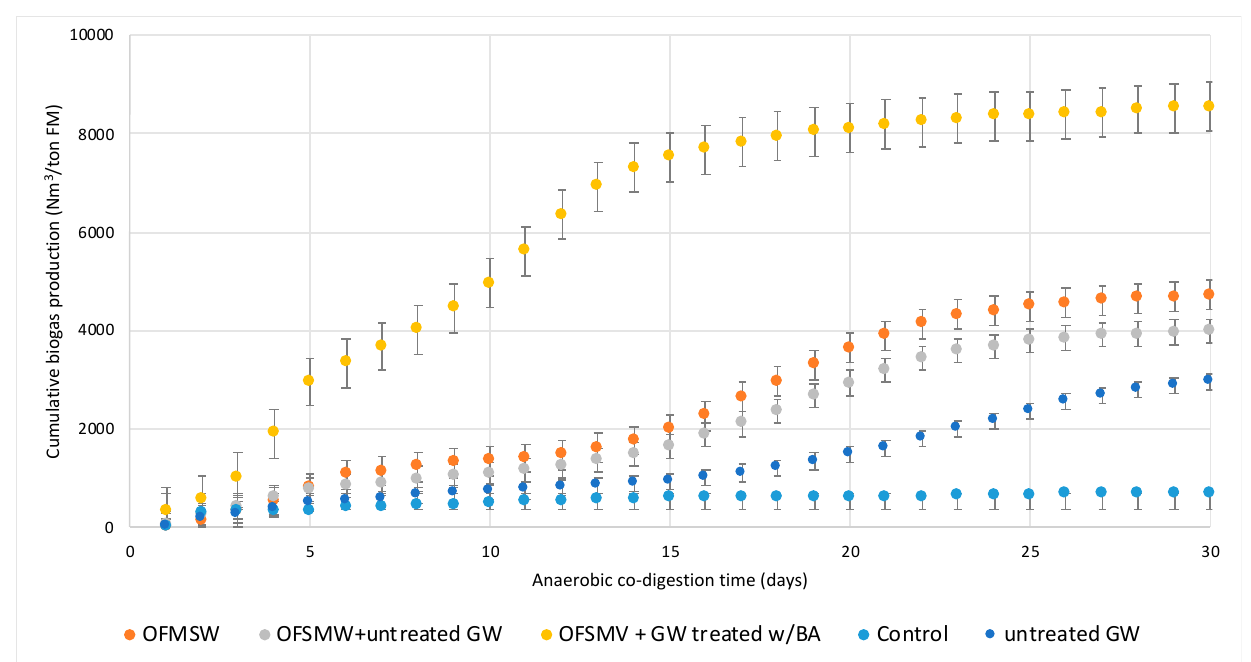
Figure 1. Cumulative biogas production during anaerobic co-digestion of OFMSW and GW, treated with BA and untreated, compared with AD of OFMSW and untreated GW. Control corresponds to the sole inoculum AD without the addition of biomass. Data are expressed as Nm 3 of biogas per ton of FM (OFMSW = organic fraction of municipal solid waste; GW = green waste; BA = Bjerkandera adusta ; AD = anaerobic digestion; FM = fresh matter).